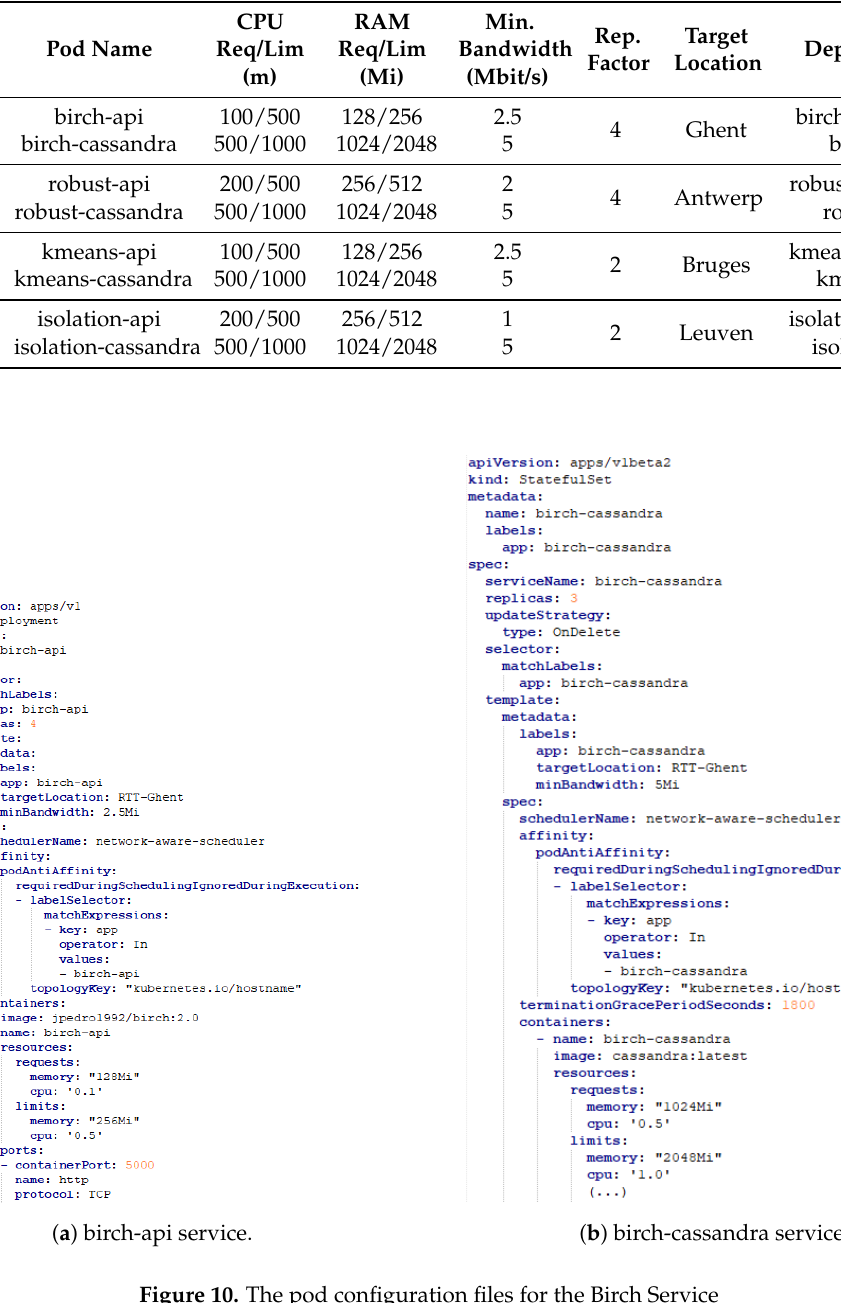
Figure 10. The pod configuration files for the Birch